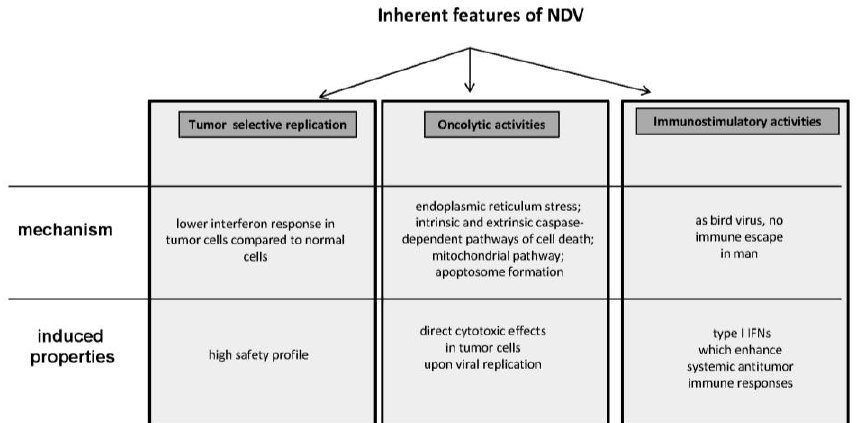
Figure 2. Newcastle Disease Virus: its three main inherent features (see the main text for more